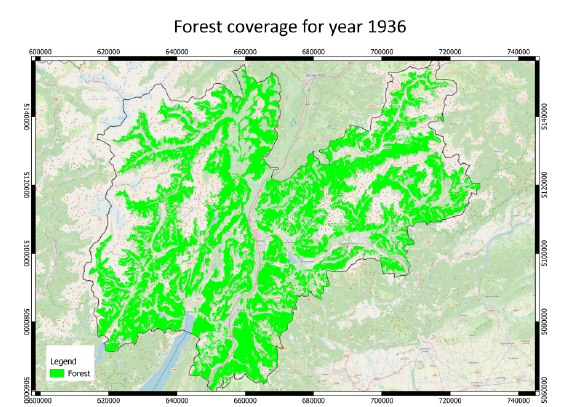
Figure 9. Forest coverage in the Trentino region in 1936.